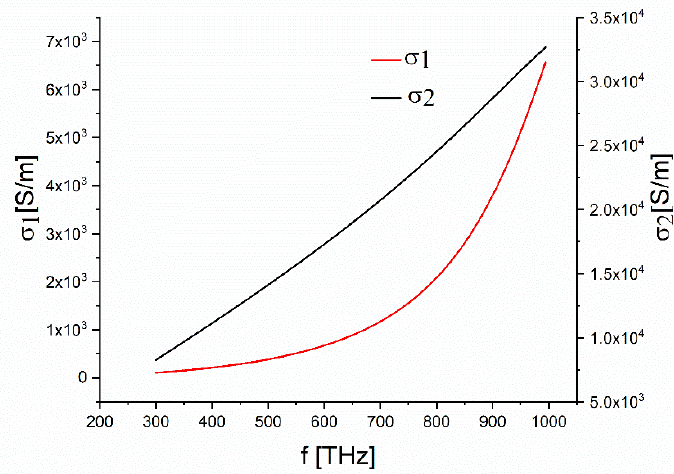
Figure 8. The optical conductivity dependence on frequency of GO films on glass substrates.